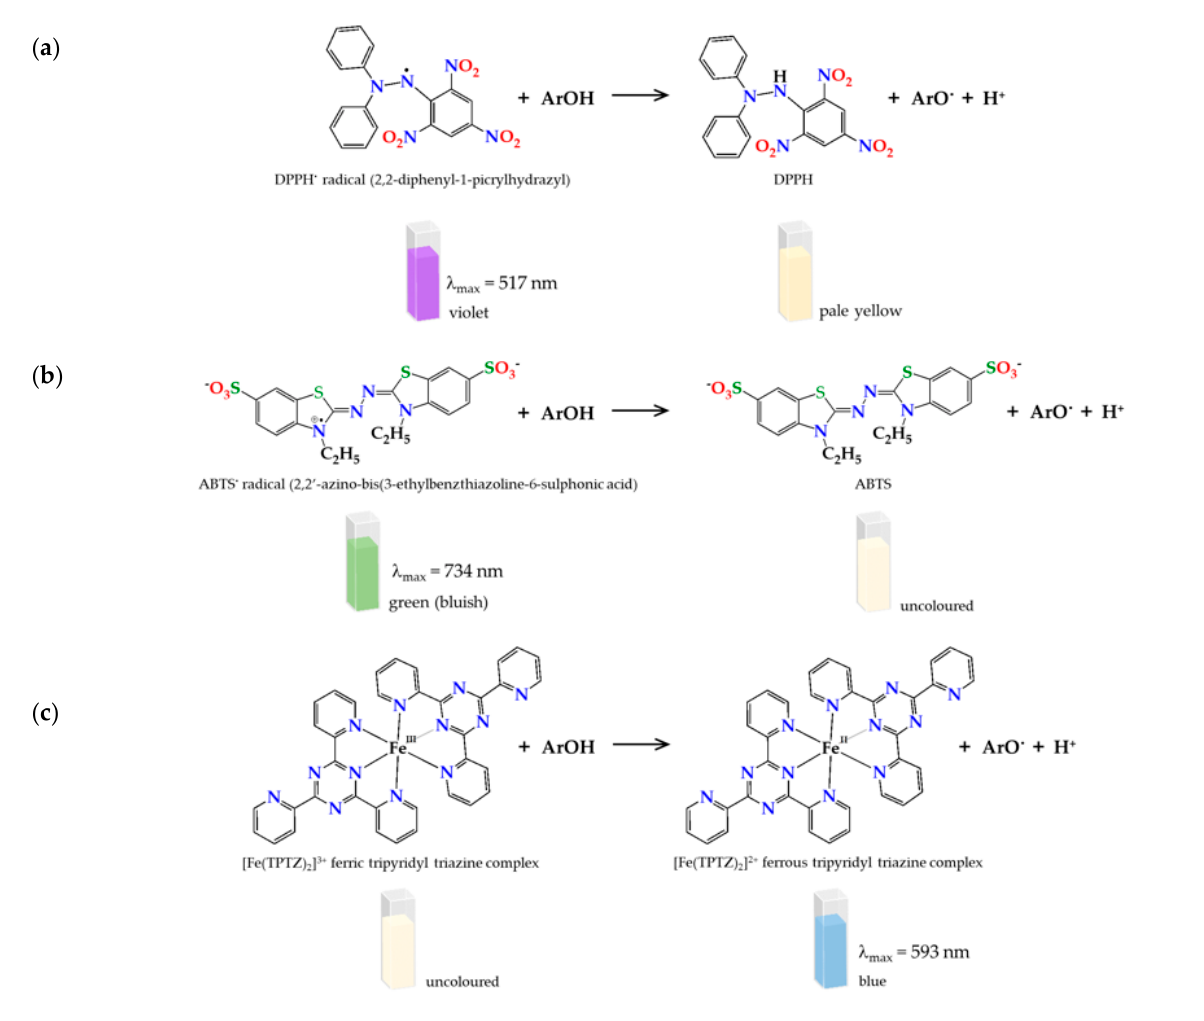
Figure 1. Radical scavenging reaction mechanism for ( a ) 2,2-diphenyl-1-picrylhydrazyl (DPPH), ( b ) 2,2 ′ -azino-bis(3-ethylbenzothiazoline-6-sulfonic acid) (ABTS), and ( c ) Ferric Reducing Antioxidant Power (FRAP).